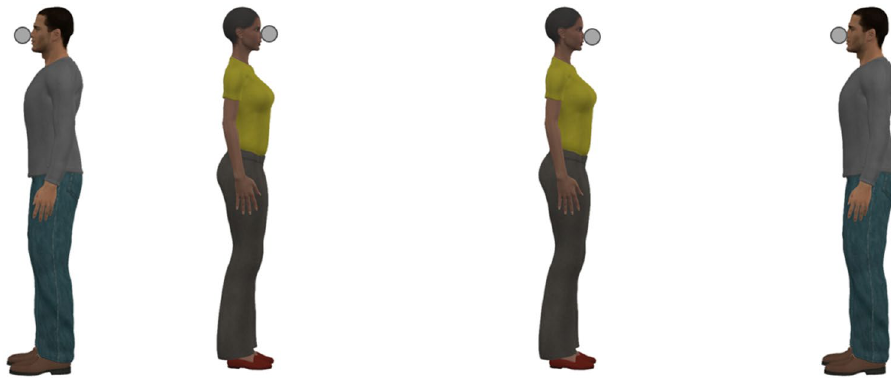
Figure 4. The Müller-Lyer illusion induced by whole-body stimuli. The target circles are the same distance apart in the left and right arrangement, but they appear closer together in the arrangement on the